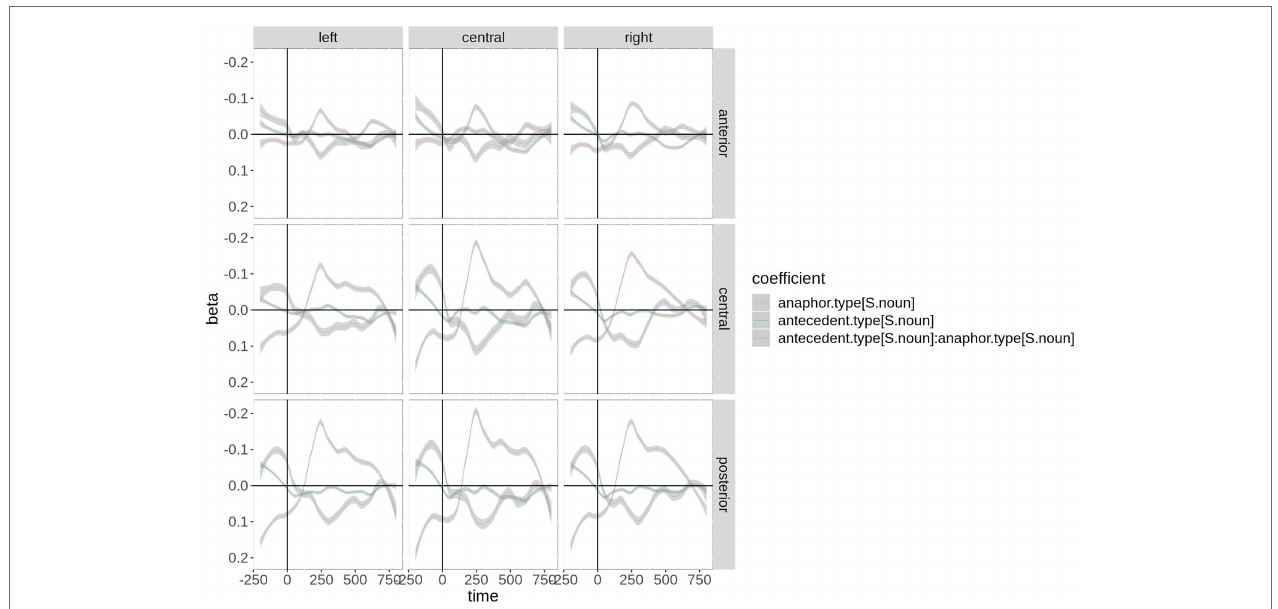
FIGURE 2 | Time course of the beta coefficients of the critical predictors and their interaction by region-of-interest (ROI). For plotting purposes, the continuous topographic variables were grouped into ROIs based on two-dimensional coordinates. Shaded areas represent 83% confidence intervals (an approximation to the traditional 0.05 level of significance for visualization